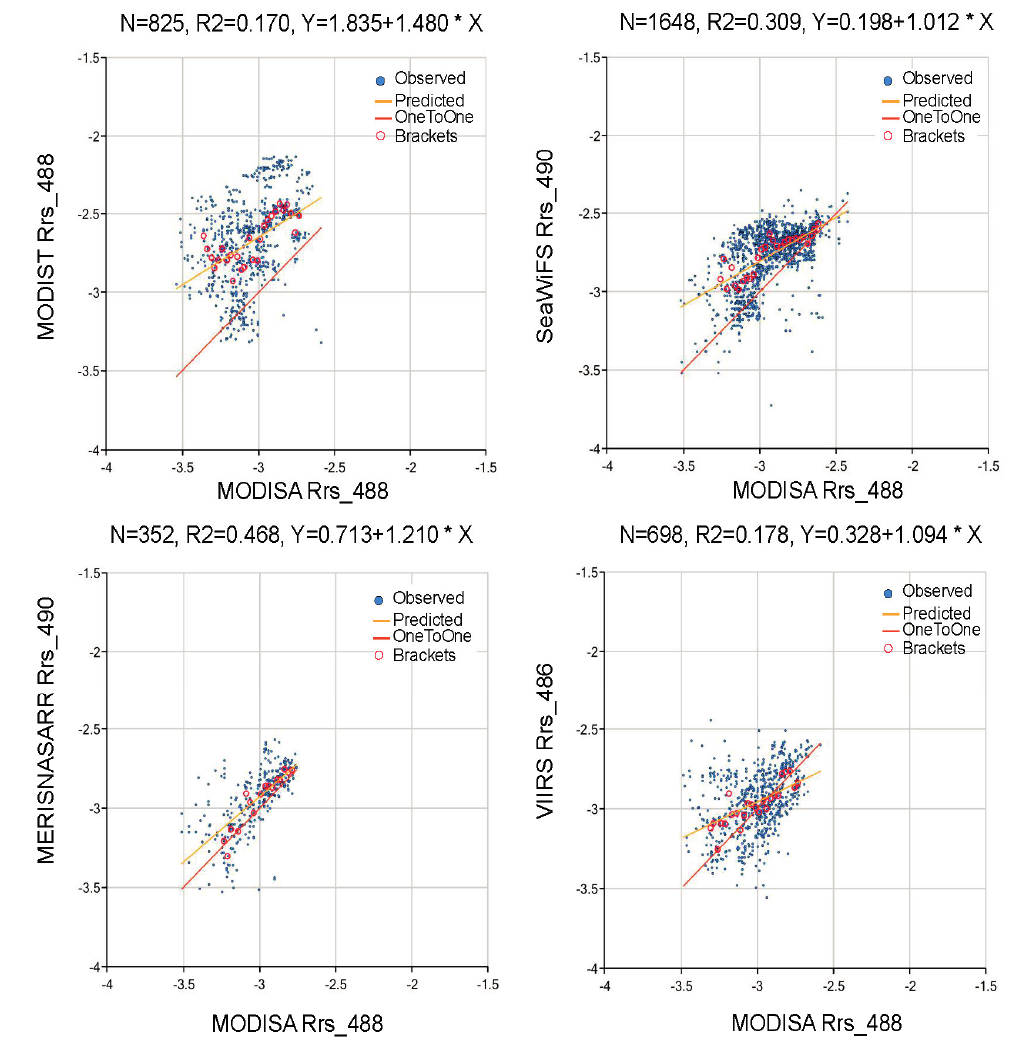
Figure 7. Inter-sensor comparison of log -transformed remote sensing reflectance ( Rrs ) at 10 approximately 490 nm as in Figure 6, but only for the subset of MODISA pixels with Rrs _488/ Rrs _547 < 0.8. According to the standard MODISA OC3 algorithm, these pixels correspond to Chla ≥ 3.3 mg m − 3